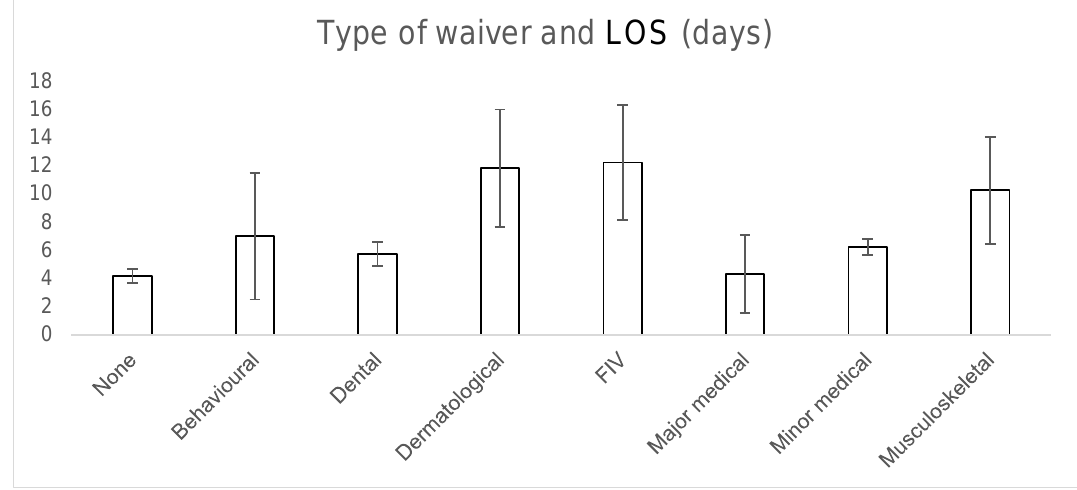
Figure 3. Effect of waiver type on LOS.